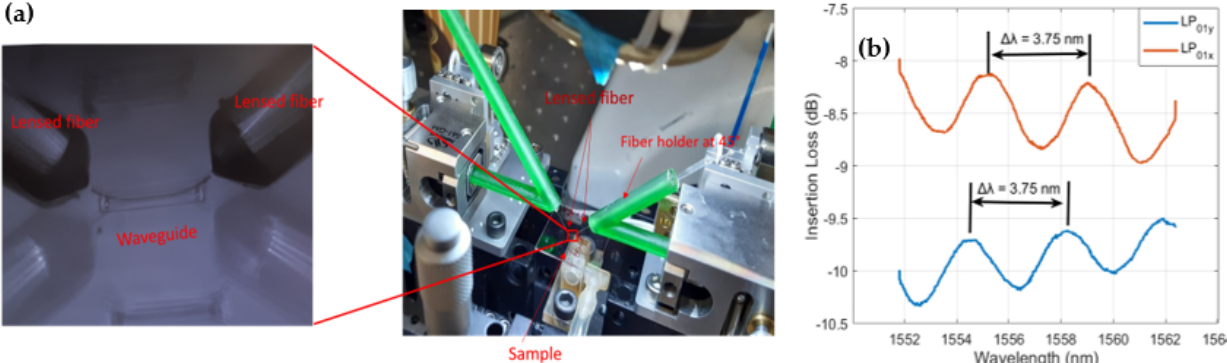
Figure 9. ( a) Experimental setup to couple to the waveguides using lensed fibers, with magnified view of the lensed fiber coupling on the left. ( b ) Transmission spectrum of printed waveguide for the two principle polarization states.